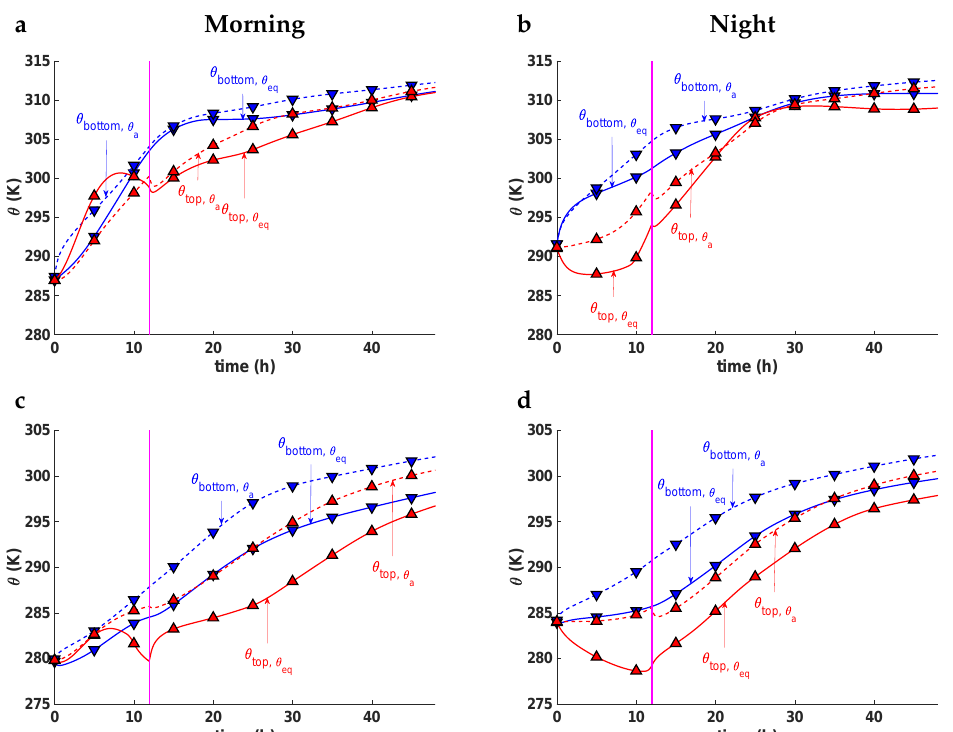
Figure 6. Here we illustrate the influence of the boundary conditions over the evolution of the concrete temperature. We have simulated the construction of a RCC dam starting on 1 April 2014, (first row), or 1 October 2014, (second row). The construction lasts 165 days and takes place in spring or autumn, respectively. The boundary conditions of our numerical models are computed through two approaches: (1) the methodology proposed in this paper, and (2) a simplified approach which only accounts for the convection between the dam surface and the air in contact with it. We compute the evolution of the concrete temperature through these two approaches: continuous lines plot the outputs of the models whose boundary conditions are computed with our methodology, and dashed lines with the simplified approach. Red lines represent the evolutions of points situated at the top of the considered lift, and blue lines the bottom. Panel ( a ) includes the evolution of the points situated in the lift at 22.8 m height and cast on 8 May 2014, at 8 a.m.—spring morning, and panel ( b ) represents sparse points of the lift at 21.9 m height and cast on 6 May 2014, at 8 p.m.—spring night. Similar results are presented for the dam construction starting in October; panel ( c ) depicts the evolutions of the points in lift at 22.8 m height and cast on 7 November 2014, at 8 a.m.—autumn day, and panel ( d ) the points in the lift